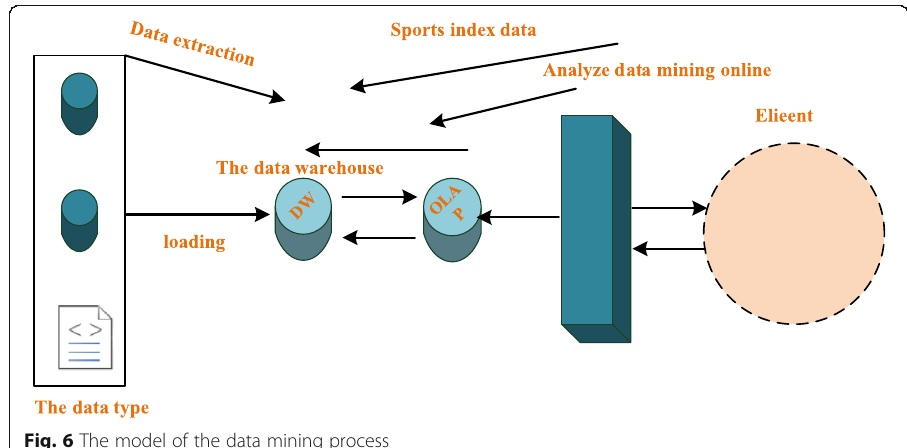
Fig. 6 The model of the data mining